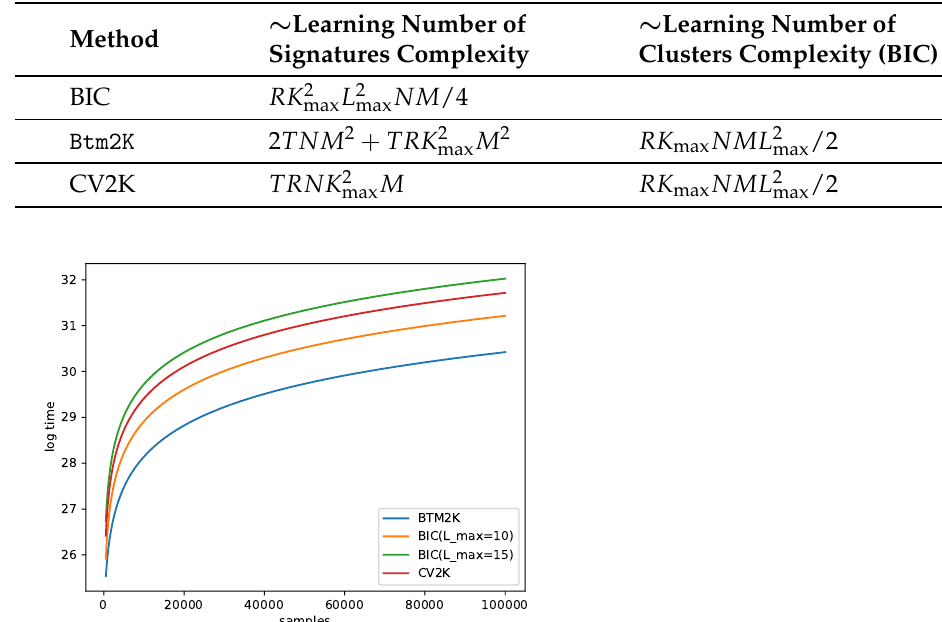
Table 1. Summary of time complexity for BIC, Btm2K , and CV2K. Here, R , N , and M denotes number of iterations to train a model (1500), samples, and categories (96). T denotes the number of repetitions of Btm2K and CV2K (30), and K max L max denotes the maximum number of signatures and clusters used when the methods iterated.